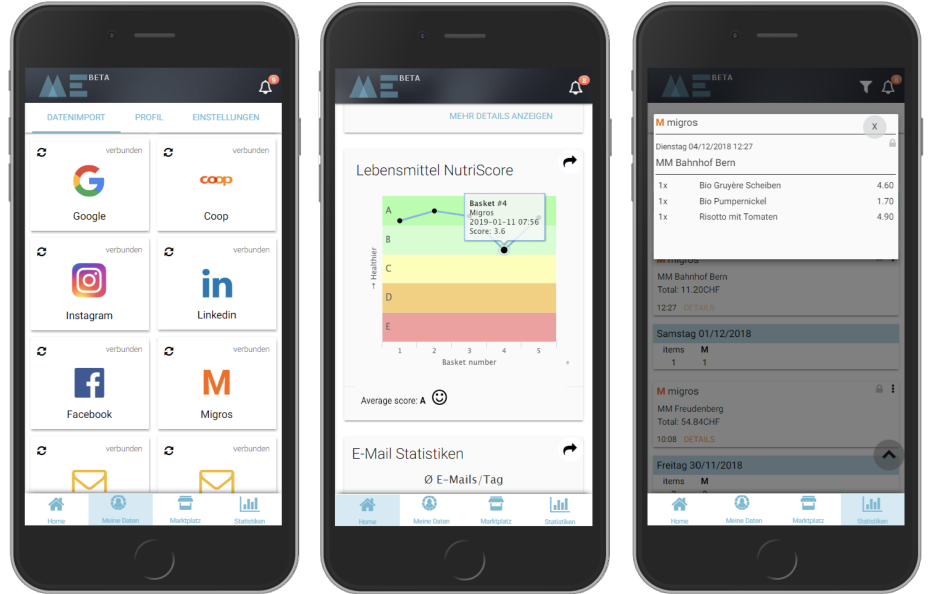
Figure 3. Enriching digital receipts with food composition data and displaying the weight-averaged Nutri-Scores of aggregated